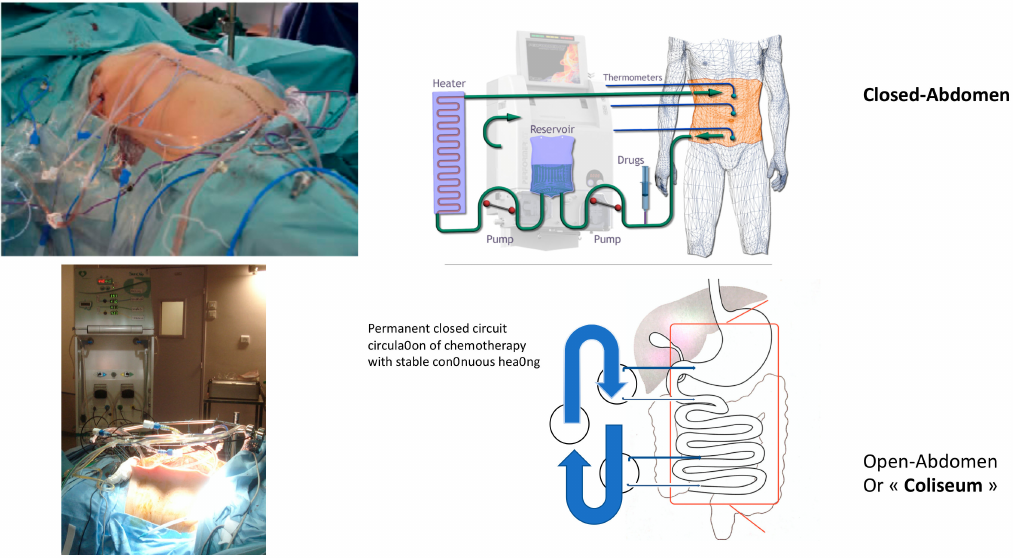
Figure 1. Hyperthermic intraperitoneal chemotherapy